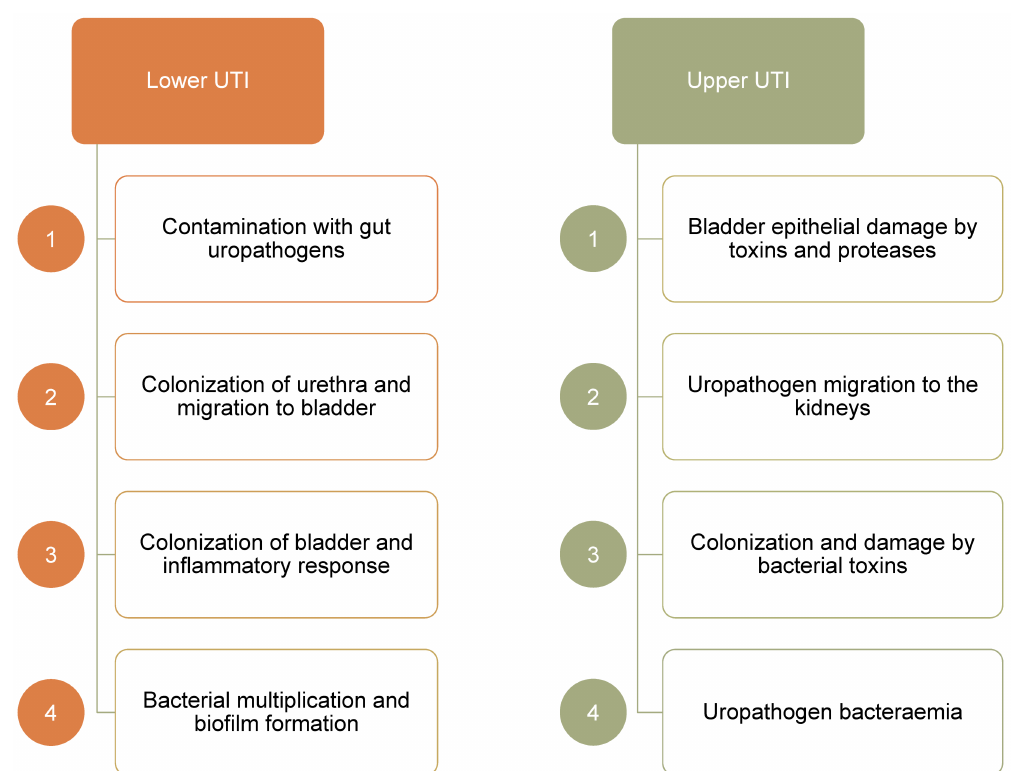
Figure 1: Urinary tract is a continuous road that can be colonized and damaged by uropathogens and uncontrolled inflammatory